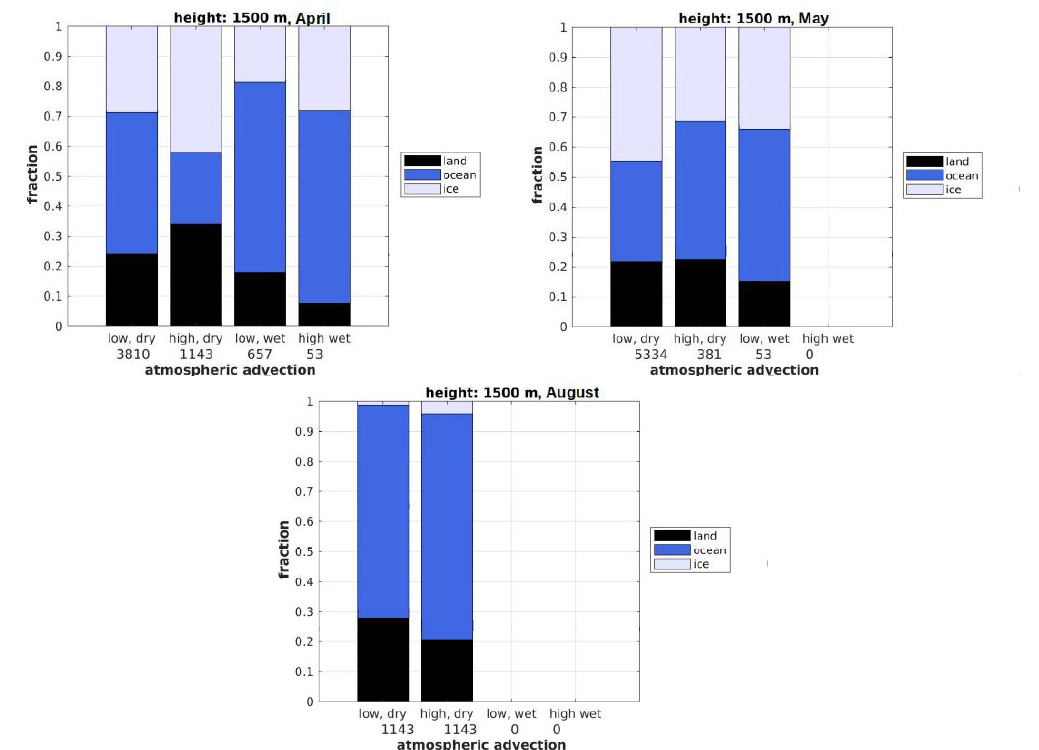
Figure 12. Fraction of how long the air parcel was over land, ocean, or ice for the months of April, May, and August and arrived at a height of 1500 m over Ny-Ålesund for the years 2013–2017. The numbers below the bars indicate the total number of points for each